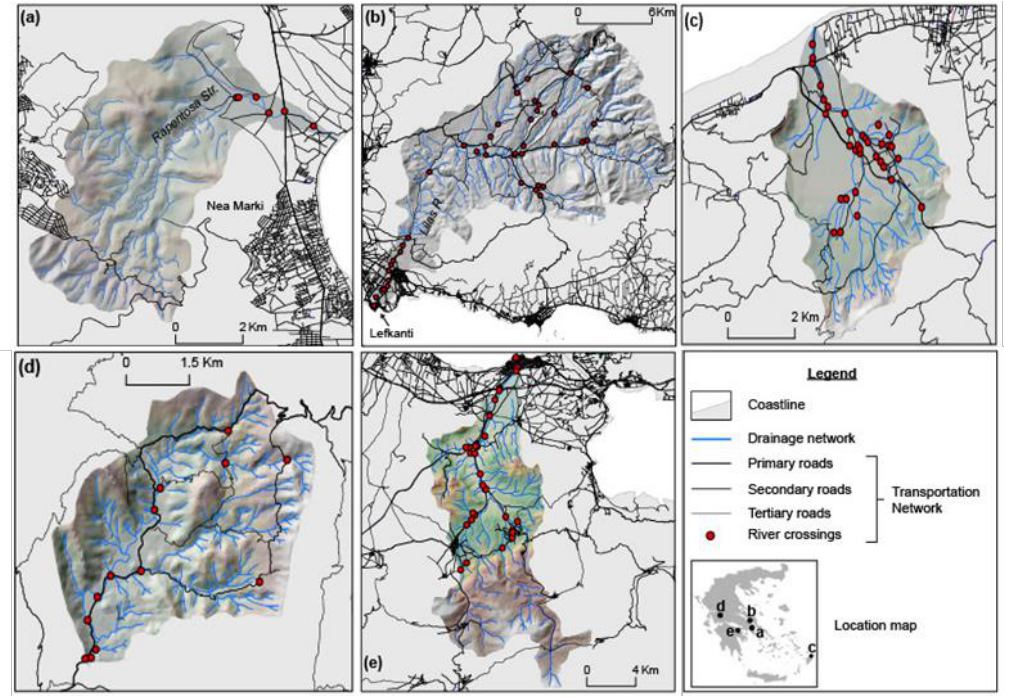
Figure 1. Maps of (a) Rapentosa, (b) Lilas, (c) Kremasti, (d) Potamoula and (e) Xerias river basins, illustrating the local drainage and the paved transportation network along with the established river crossings